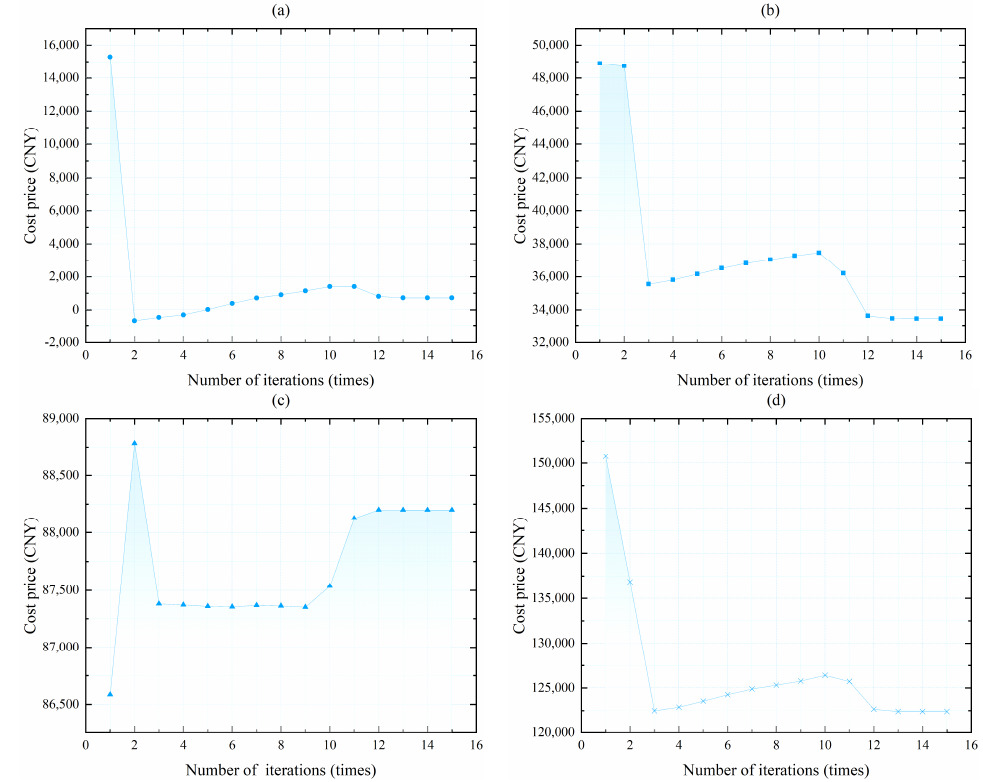
Figure 6. Convergence result of the coalition total running cost for upper-layer hot-sharing sub − problem P2. ( a ) Iterative result of the micro − grid 1 (cid:13) . ( b ) Iterative result of the micro − grid 2 (cid:13) . ( c ) Iterative result of the micro − grid 3 (cid:13) . ( d ) Iterated results of the alliance